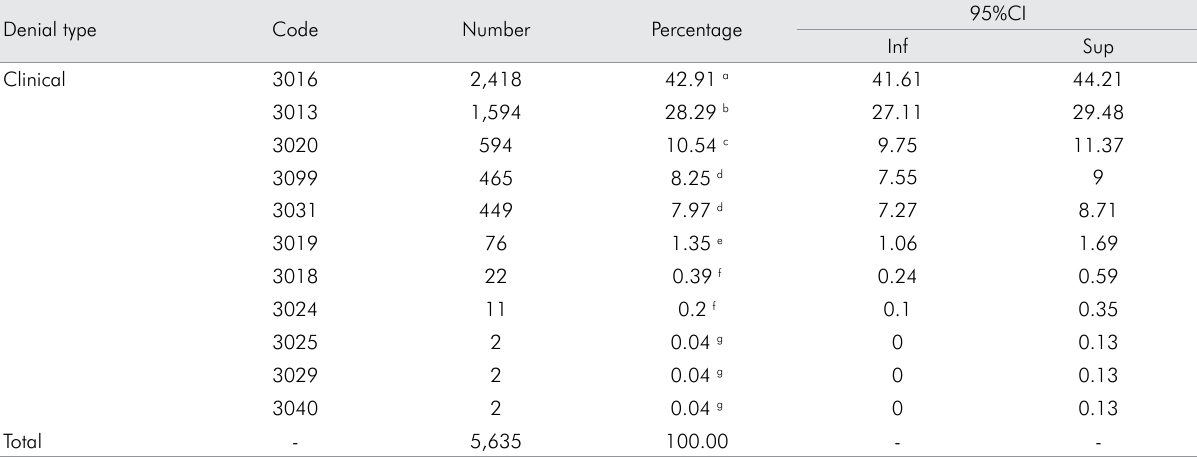
Table 4. Distribution of clinical denial